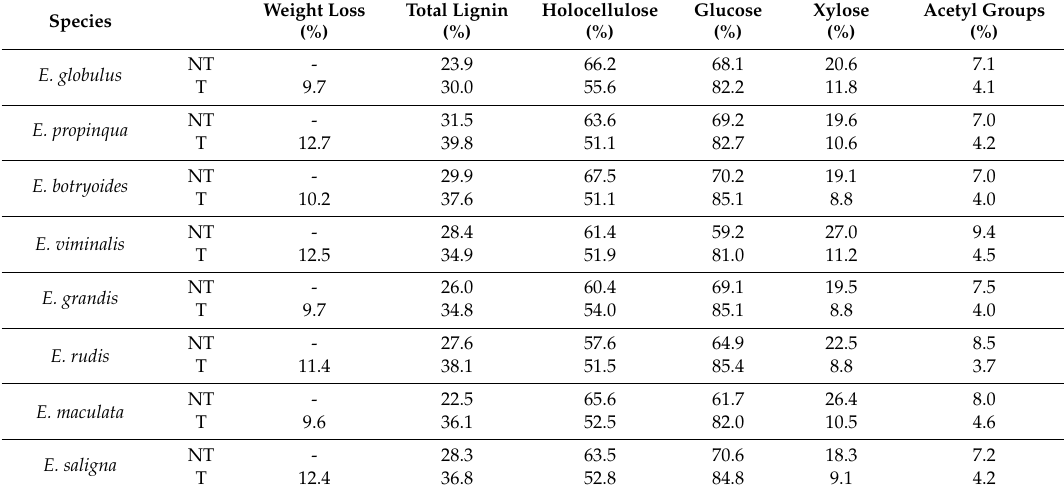
Table 1. Chemical composition (%, oven dry material) of eucalypt woods before (NT) and after (T) the thermal treatment *. Weight Loss Species